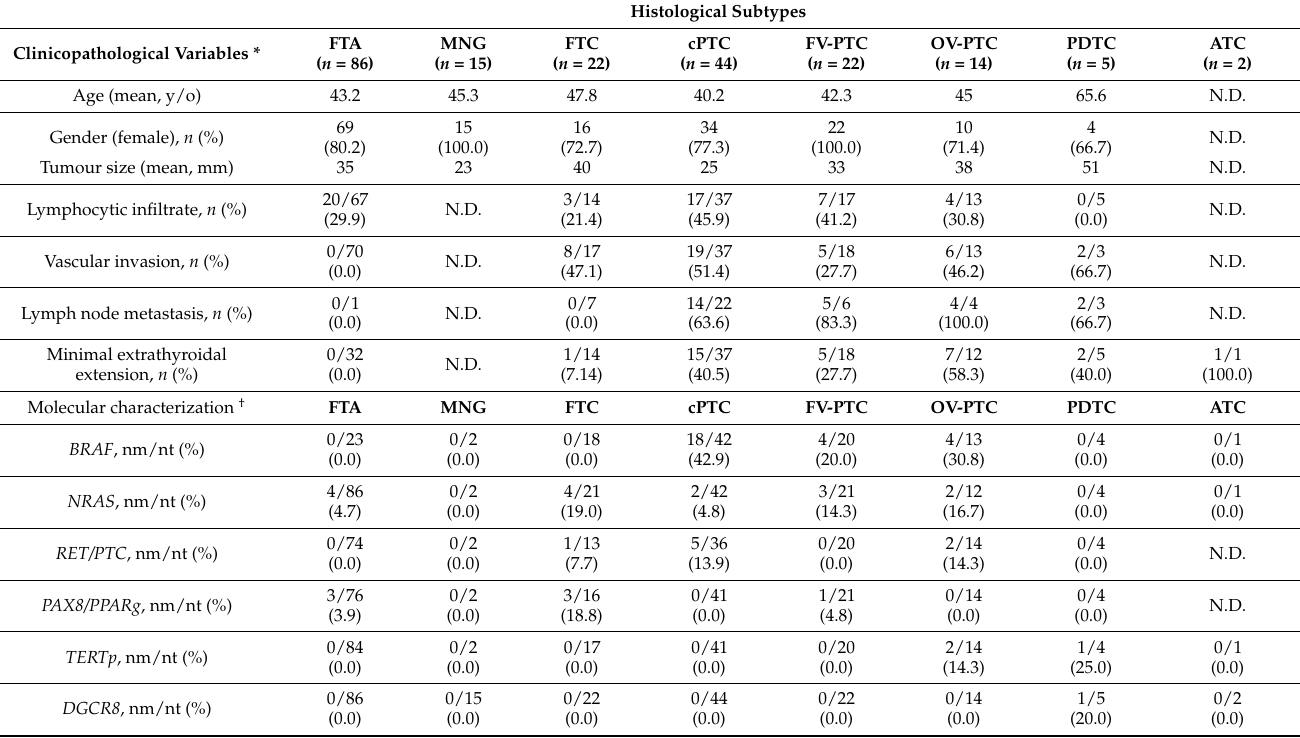
Table 1. Clinicopathological and molecular characterization of the